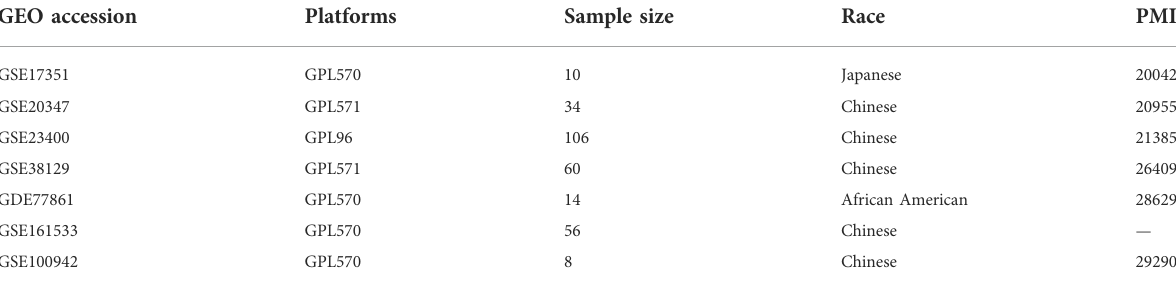
TABLE 1 Information of the GEO datasets involved in this